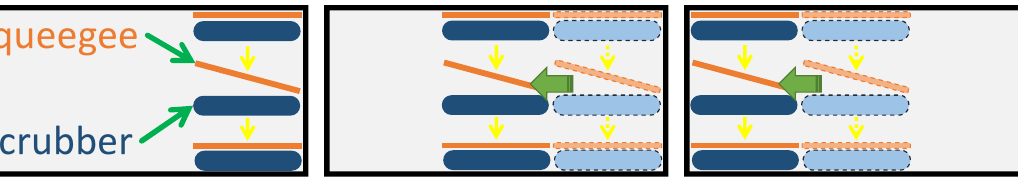
Figure 1. Two key points that need to be addressed.